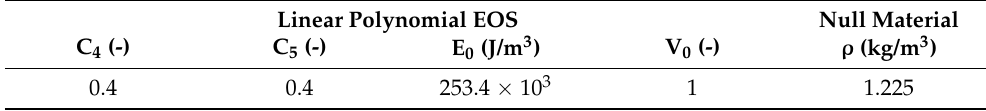
Table 6. Parameters of linear polynomial EOS and null material model for